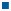
A principal-coordinate analysis plot of the oral microbiota based on the results of the unweighted UniFrac metric.Scatter plot of principal coordinate 1 (PC1) versus principal coordinate 2 (PC2) is shown. The first axis (PC1) explains the maximum amount of variation present, followed by the second axis. Percentages shown are percentages of variation explained by the components. Each point represents a single sample, and the distance between points represents the compositional difference of the samples from each other. ■: marmoset, ●: human.